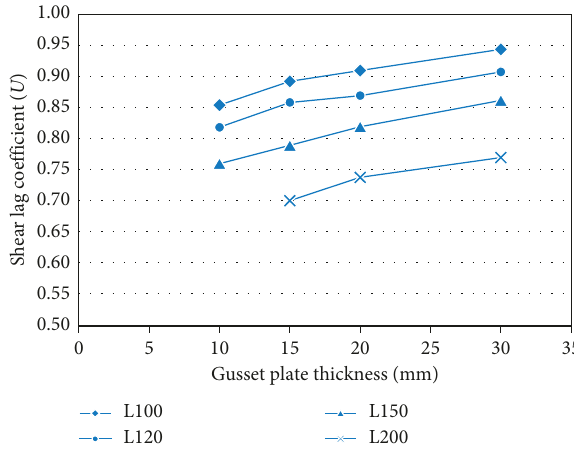
Figure 11: Effect of gusset plate thickness on the tension capacity of single angles.